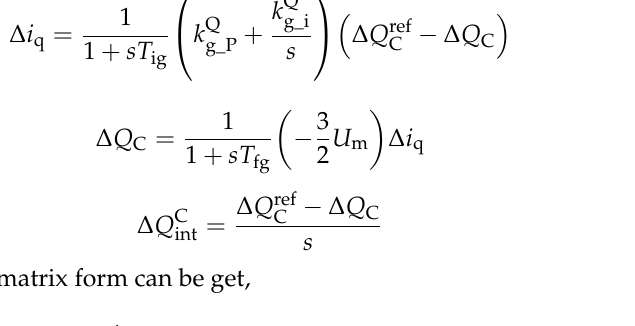
Figure 8. The reactive power control loop of the GSC.